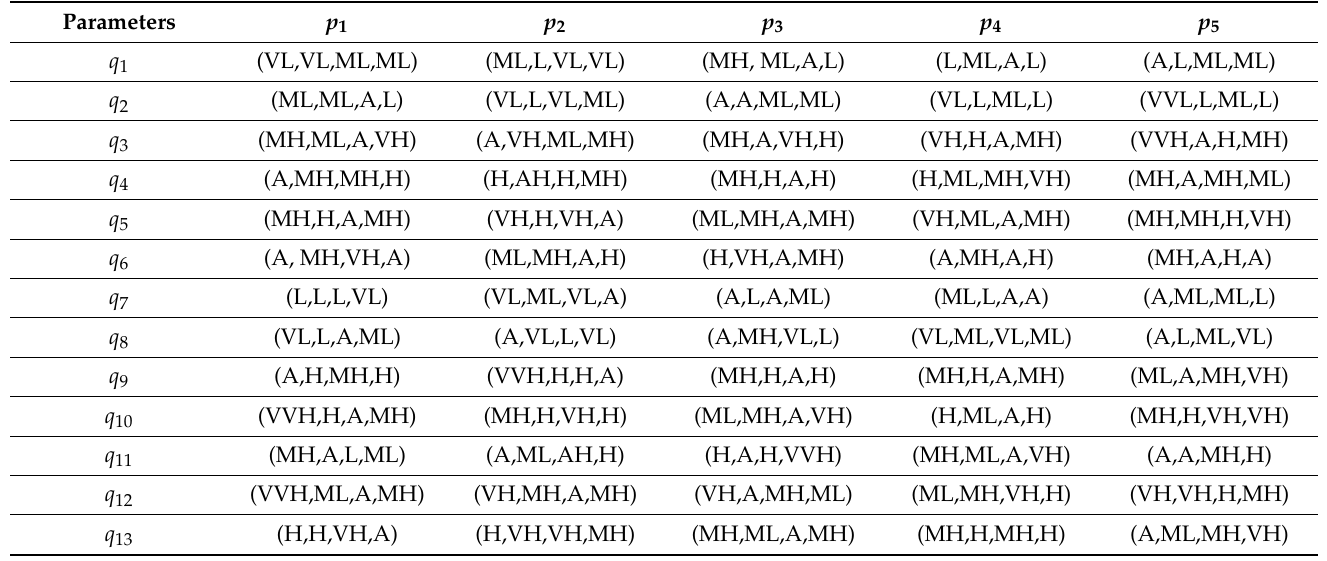
Table A1. The LDM for prioritizing the BESSs by DEs.